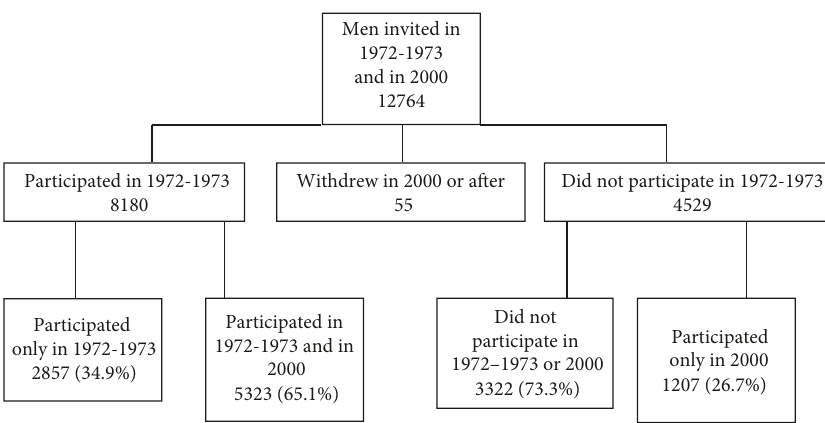
Figure 1: Flowchart of the Oslo study 1972/73 with the follow-up study Oslo II in